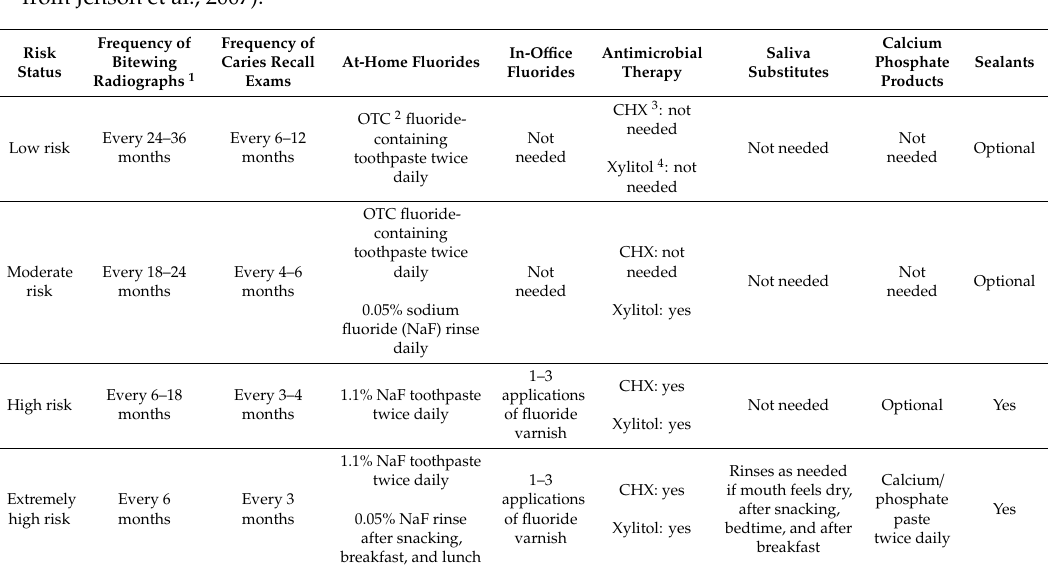
Figure 1. Percentages of female, male, and total students who answered the question regarding the CAMBRA protocol. Table 3. Caries risk assessment and management guidelines based on the CAMBRA risk levels (adapted from Jenson et al.,